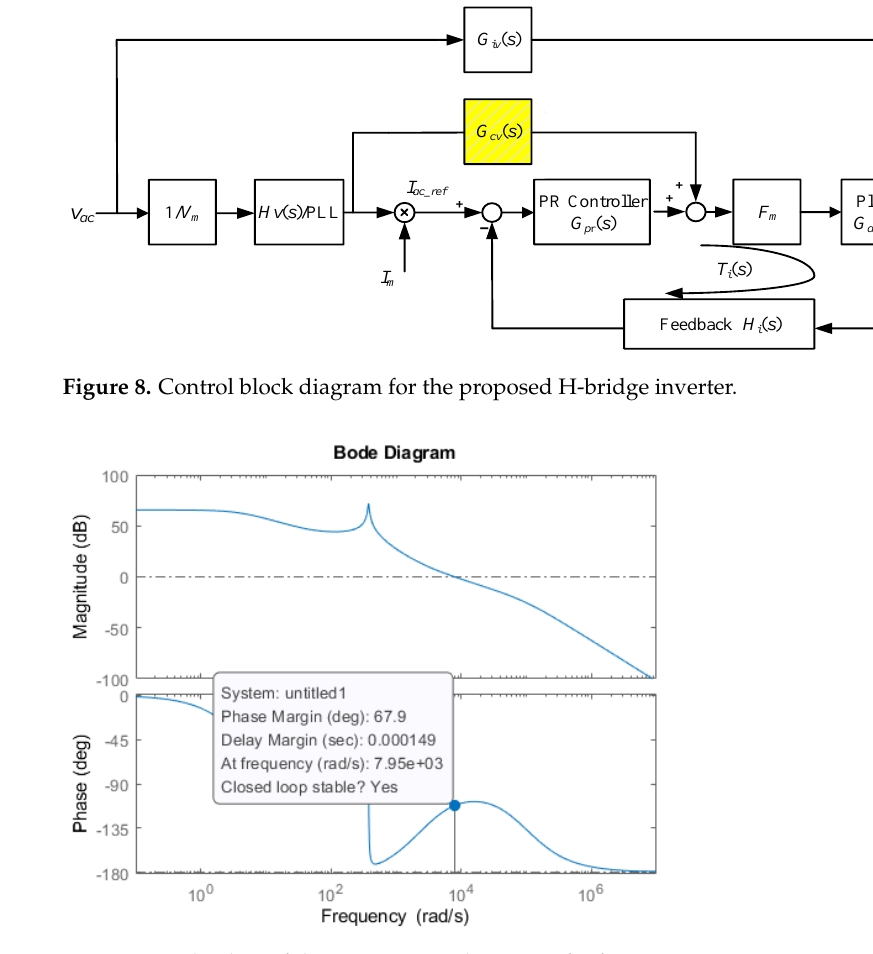
Figure 9. Bode plots of the open current loop transfer function .